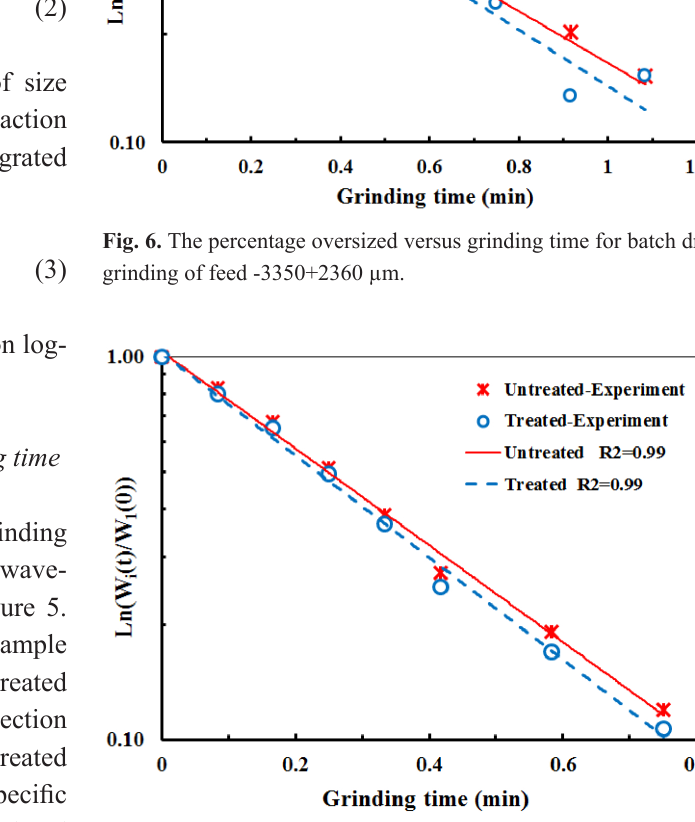
Fig. 7. The percentage oversized versus grinding time for batch dry grinding of feed -1700+1180